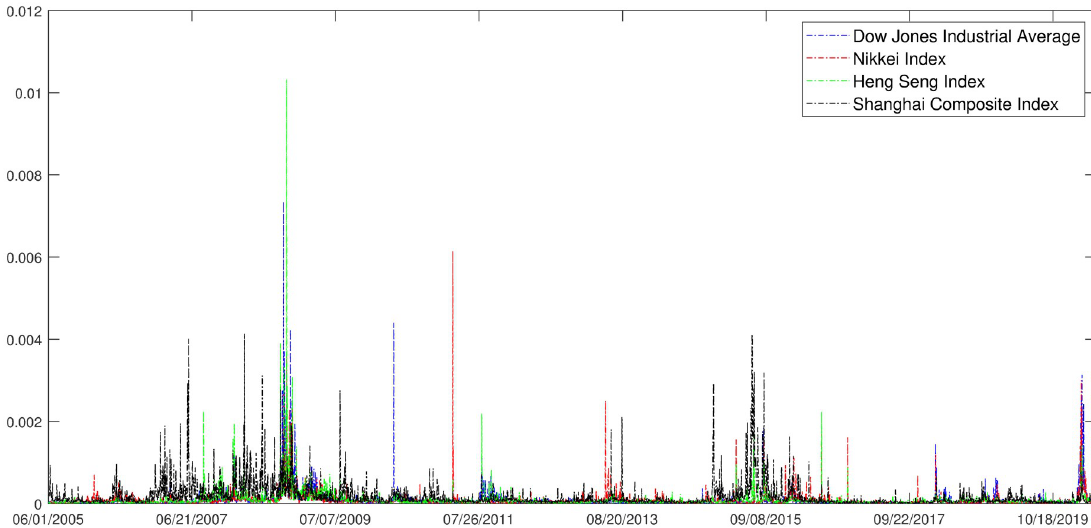
Fig 5. Comparison of volatilities in four stock markets. Daily return volatility for Dow Jones Industrial Average Index(blue), Nikkei Index(red), Heng Seng Index(green) and Shanghai Composite Index(dark).